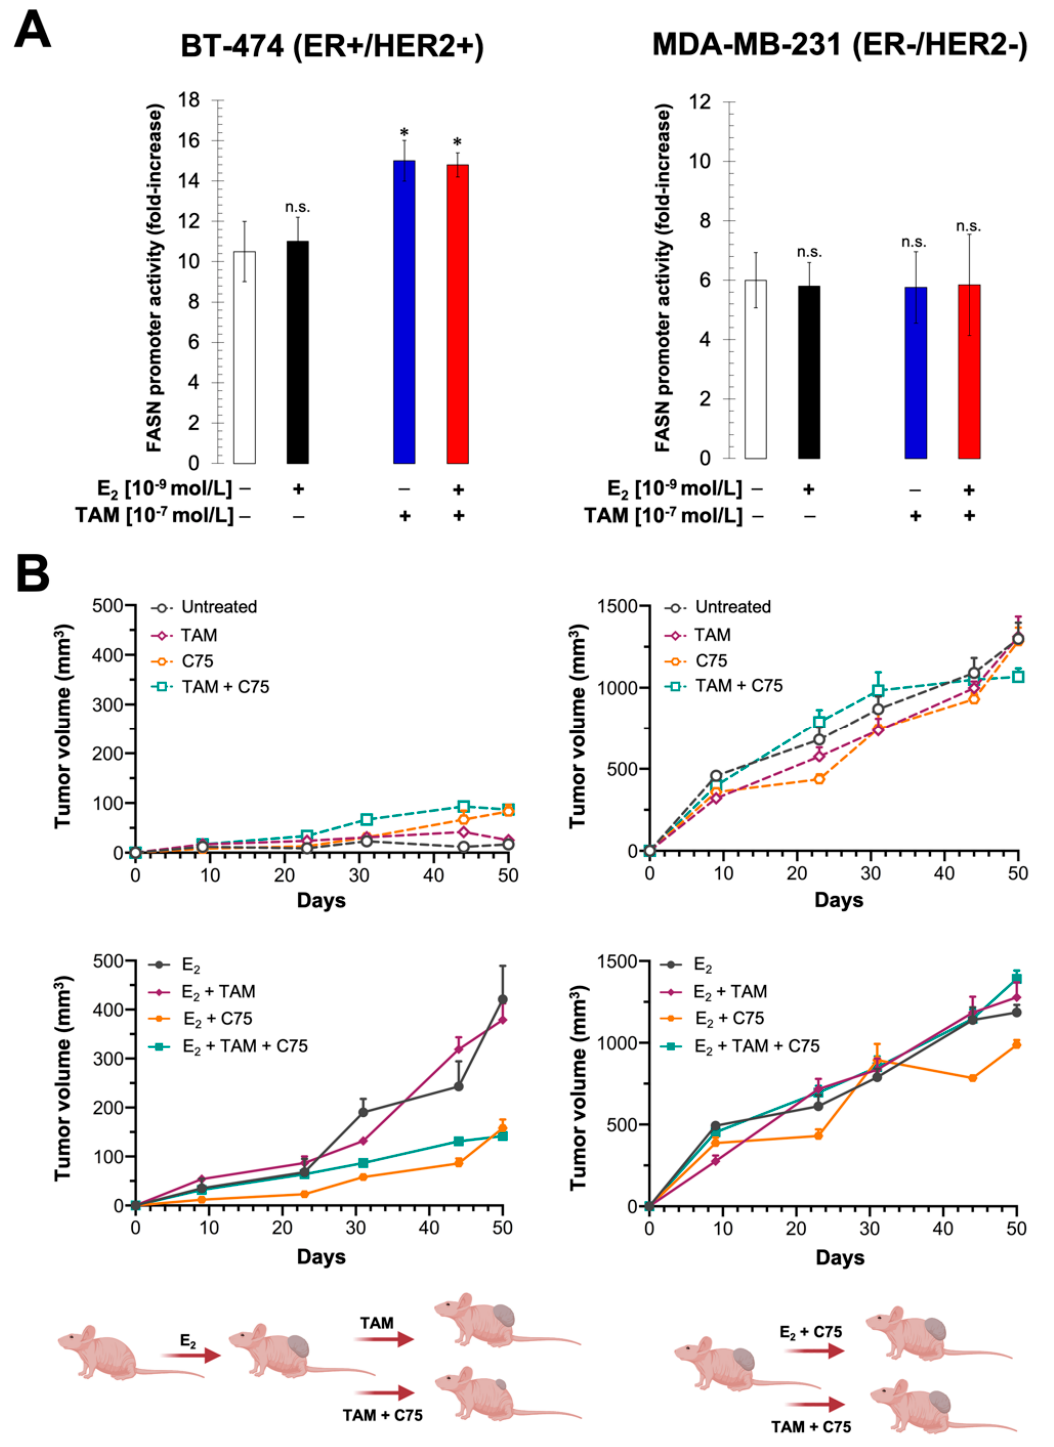
Figure 6. FASN inhibition suppresses primary resistance to tamoxifen of BT-474 tumors. ( A ) FASN promoter activity in BT-474 (left) and MDA-MB-231 (right) cells cultured in the presence or absence of estradiol (E 2 ) tamoxifen (TAM), or the E 2 plus TAM combination, was carried out as in Figure 1B. * p < 0.005; ( B ) Growth of BT-474 (left panels) and MDA-MB-231 (right panels) xenograft tumors in athymic female mice treated with C75 in the absence or presence of estrogen (E 2 ) or tamoxifen. The maximum length for each treatment was 50 days. Results are presented as the mean tumor volume ± S.D. ( n = 10 mice/experimental group). n.s. not significant